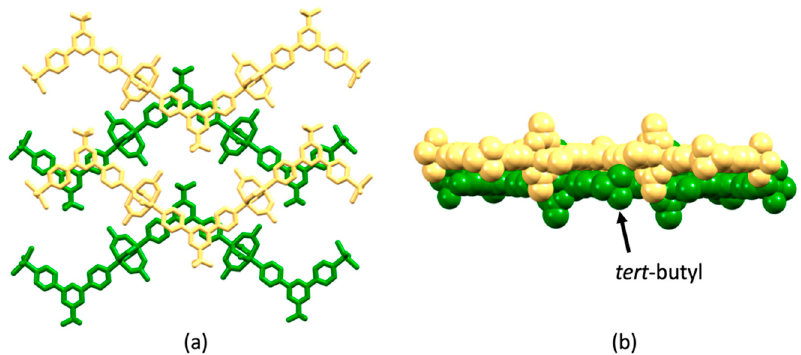
Figure 18. ( a ) Stacking of zigzag chains in [Zn 2 ( µ -OAc) 4 ( 24 )] n (CSD refcode FAKROA) with π - Figure 18. (a) Stacking of zigzag chains in [Zn 2 ( μ‐ OAc) 4 ( 24 )] n (CSD refcode FAKROA) with π‐ stacking between 4,2’:6’,4” ‐ tpy units, and (b) a space ‐ filling representation of the chains shown in stacking between 4,2 (cid:48) :6 (cid:48) ,4 (cid:48)(cid:48) -tpy units, and ( b ) a space-filling representation of the chains shown (a) viewed from the side to show the location of a tert ‐ butyl group between a pair of acetato units in the adjacent layer.